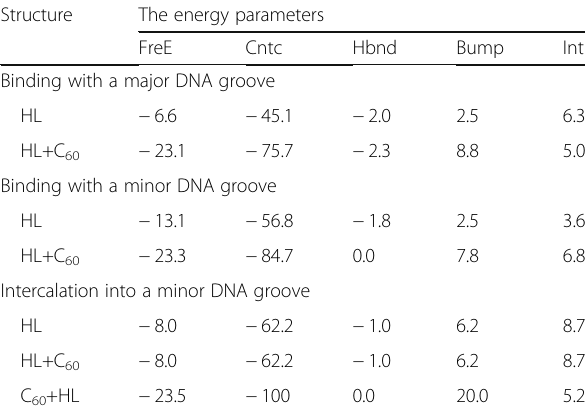
Table 1 Energy parameters (kJ/mol) of diphenyl-N-(trichloroacetyl)- amidophosphate (HL) interaction alone and in combination with C 60 fullerene with DNA double-helix Structure